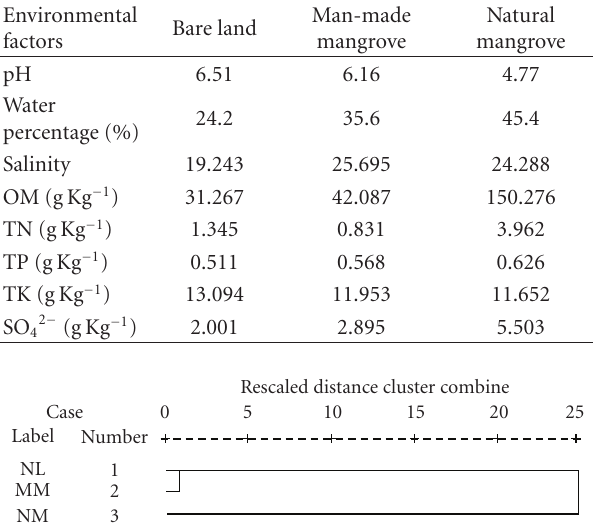
Table 1: Main physical/chemical factors at the three habitats of the mangrove forest [10].